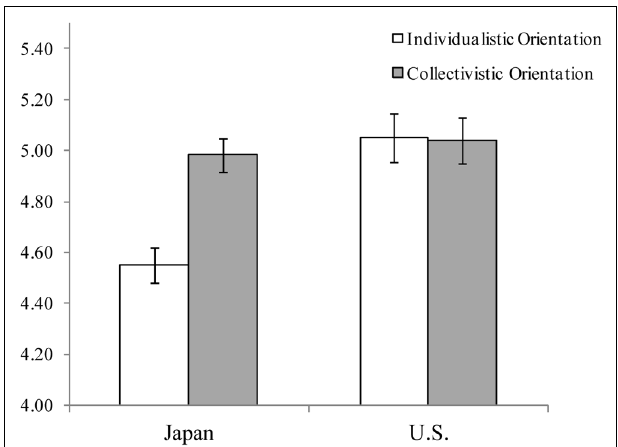
FIGURE 1 | Raw scores of individualistic and collectivistic orientations in Japan and the U.S. (Study 1). Bars represent the standard